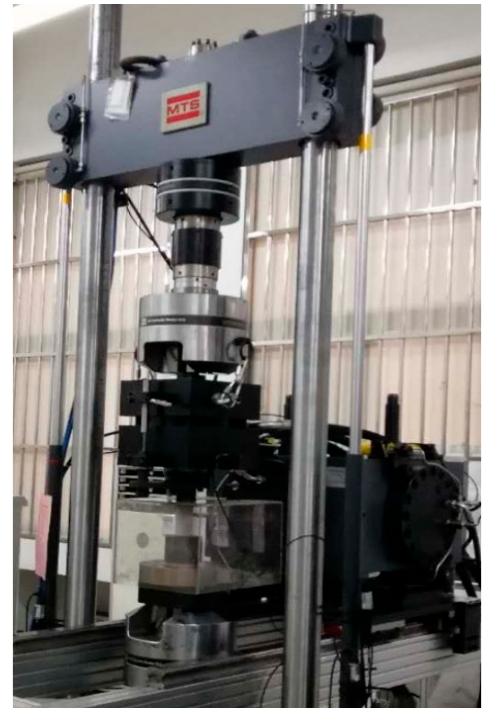
Figure 1. Test equipment.